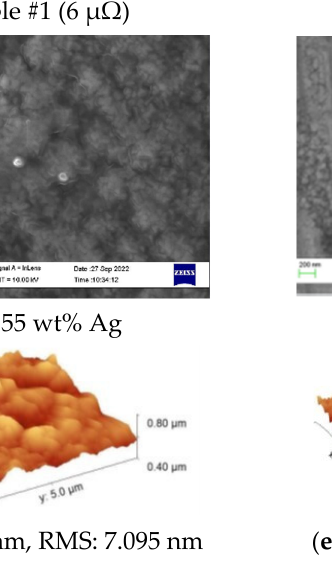
Figure 21. FESEM and EDX Analysis of the Coated Sample: ( a )–( c ) wt% Ag and ( d )–( f ) Ra and RMS value.